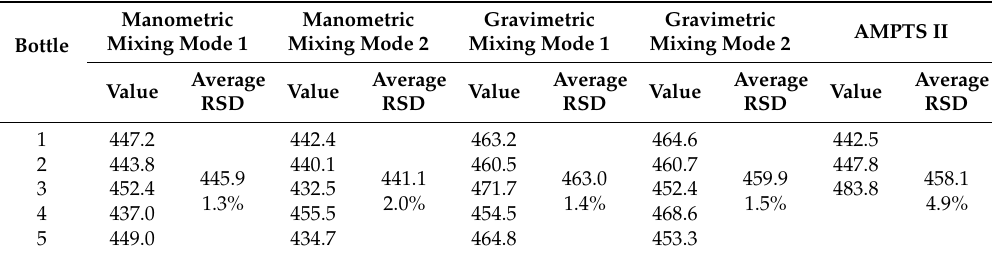
Table 3. Specific methane production from cellulose tests without correction for inoculum (mL CH4 / g VS of cellulose) measured by di ff erent